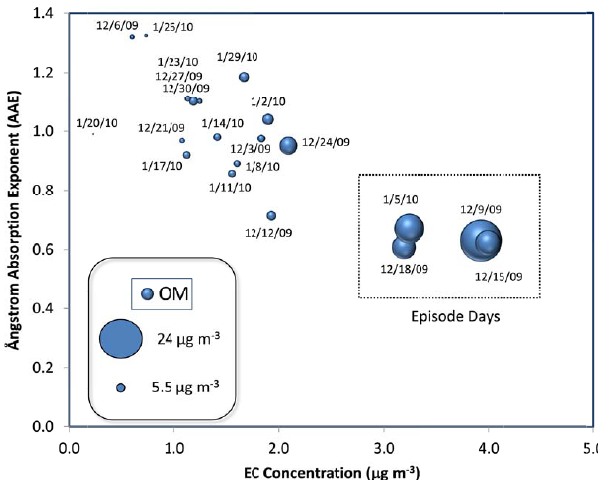
Fig. 6. ˚ Angstrom Absorption Exponent (AAE) as a function of el- emental carbon (EC) and organic material (OM) concentration. Di- ameter of the spheres is proportional to the OM concentration where OM = 1.4×OC. Episode days exceeding the USEPA 24-h PM 2 . 5 National Ambient Air Quality Standard (NAAQS) of 35µgm − 3 are